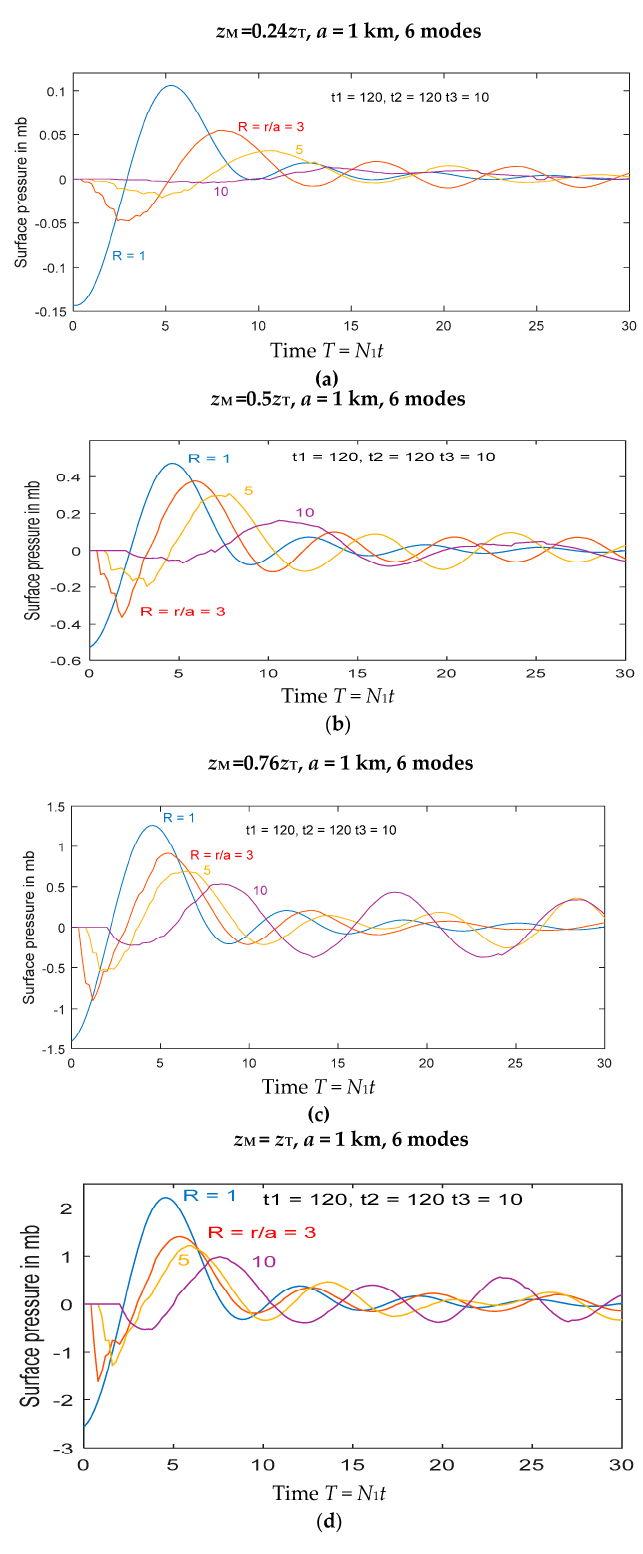
Figure 4. The time series of surface pressure signals in mb, forced at radius a = 1 km, at distances R = r / a = 1, 3, 5 and 10, for eruptions of short duration that reach maximum heights z M where ( a ) z M / z T = 0.24, ( b ) 0.5, ( c ) 0.76 and ( d ) 1. Here, z T = 14 km, and H s = 9 km, and h n coefficients are given in Figure A1. The eruption grows linearly for a period of 2 min, and then decays rapidly with an exponential time scale of 10 s. Note the increasing amplitude with z M , and the general similarity between the various